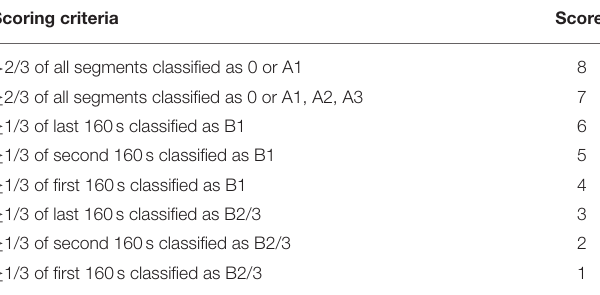
TABLE 1 | Scoring criteria of the arousal stability index. Scoring criteria